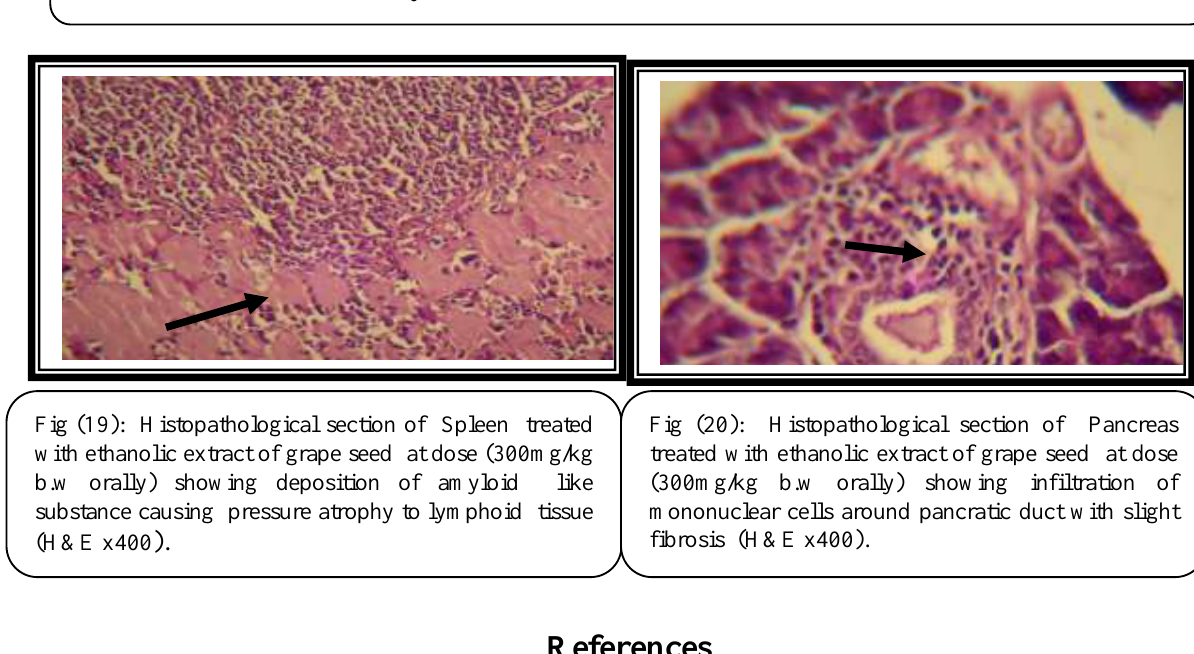
Fig(18) :Histopathological section of Kidney of mouse treated with ethanolic extract of grape seed at dose (300mg/kg b.w I/P) showing severe periglomerular infiltration of inflammatory cells ( )and cystic of renal tubules with formation of hyaline cast ( ) (H & E